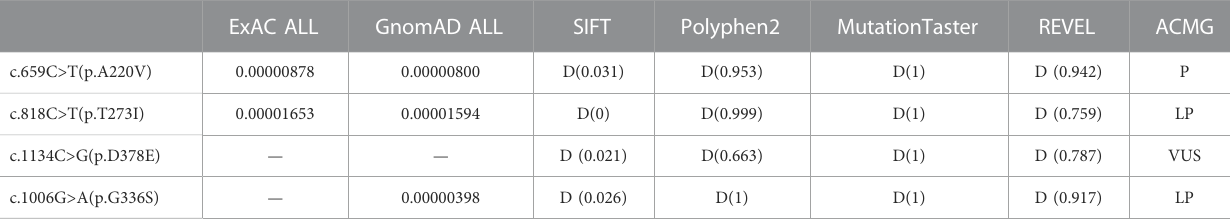
TABLE 3 Bioinfomatic analysis of missense